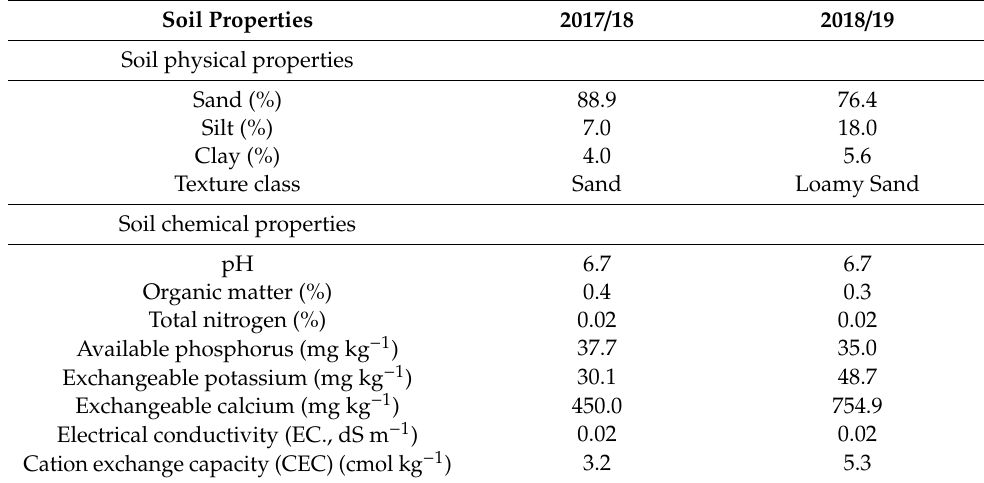
Table 1. Soil physical and chemical properties of field experiments in 2017 / 18 and 2018 /